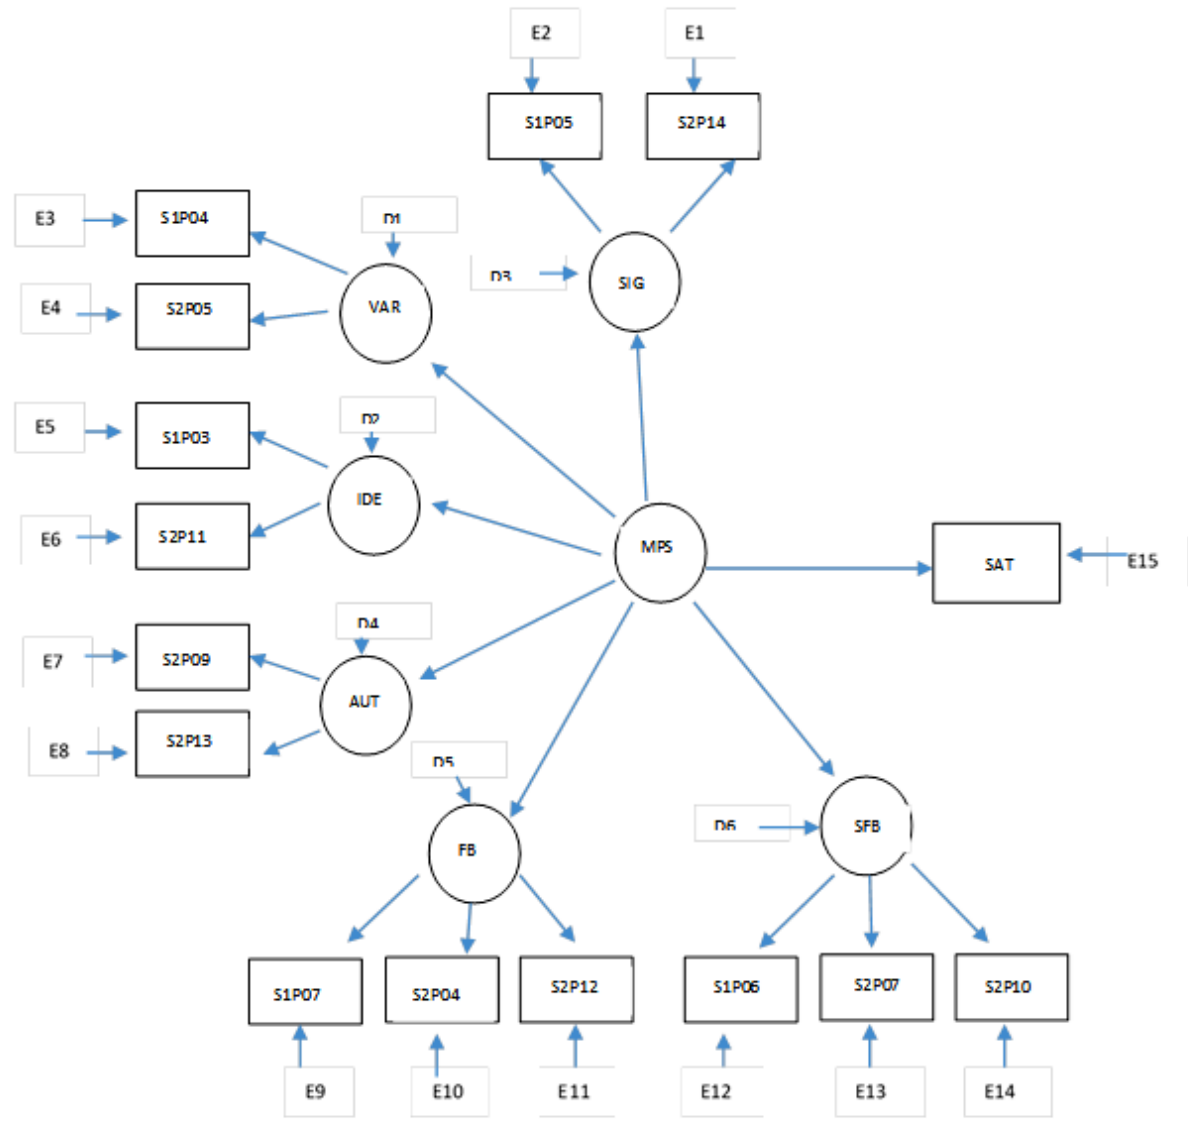
Figure 1. Model for the second-order factor model of teaching adapted version of JDS (Latent factor with acronym in parentheses. “significance” (SIG); “variety” (VAR); IDE=identity; AUT=autonomy; FB=feedback from the job itself; SFB=feedback from agents; SAT=Satisfaction. Items or observable variable were reverse coded are denoted with